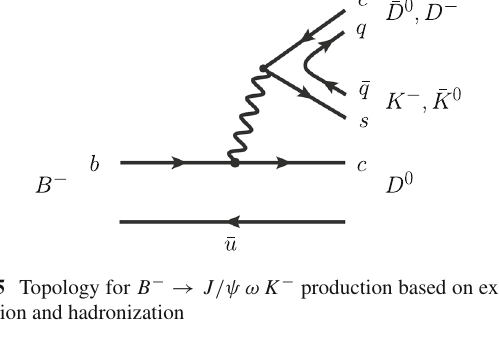
Fig. 5 Topology for B − → J /ψ ω K − production based on external emission and hadronization